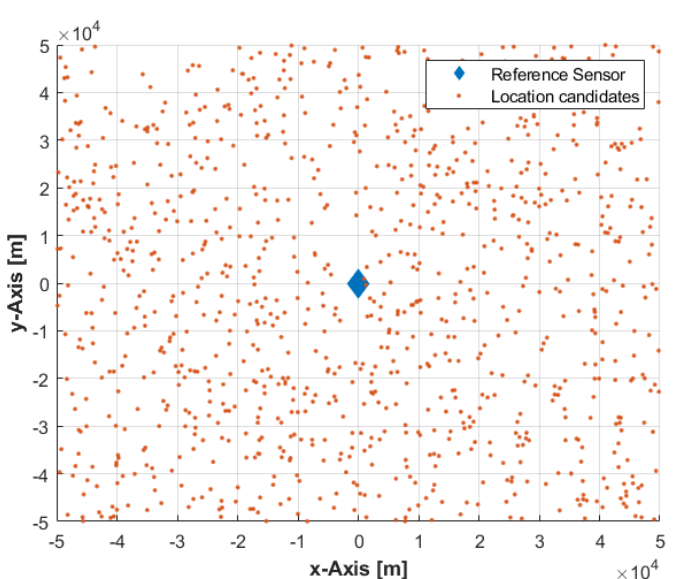
Figure 3. The set of uniformly distributed random emitter location candidates within the solution space corresponds to the reference sensor coverage.